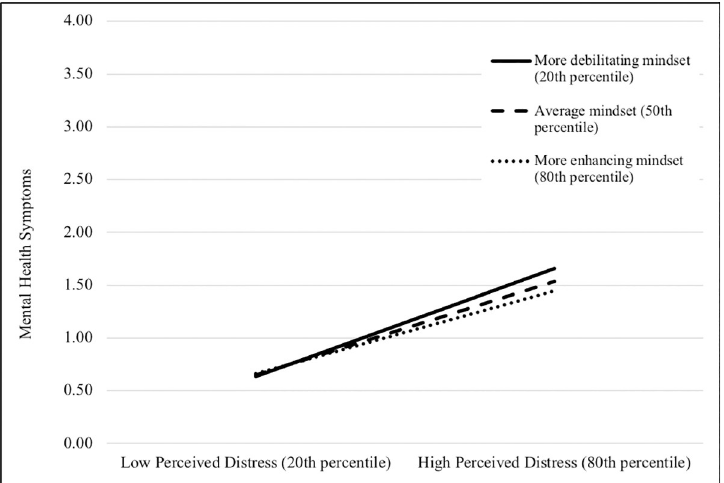
Fig 1. Graphical representation of interaction between perceived distress and general stress mindset predicting mental health symptoms.